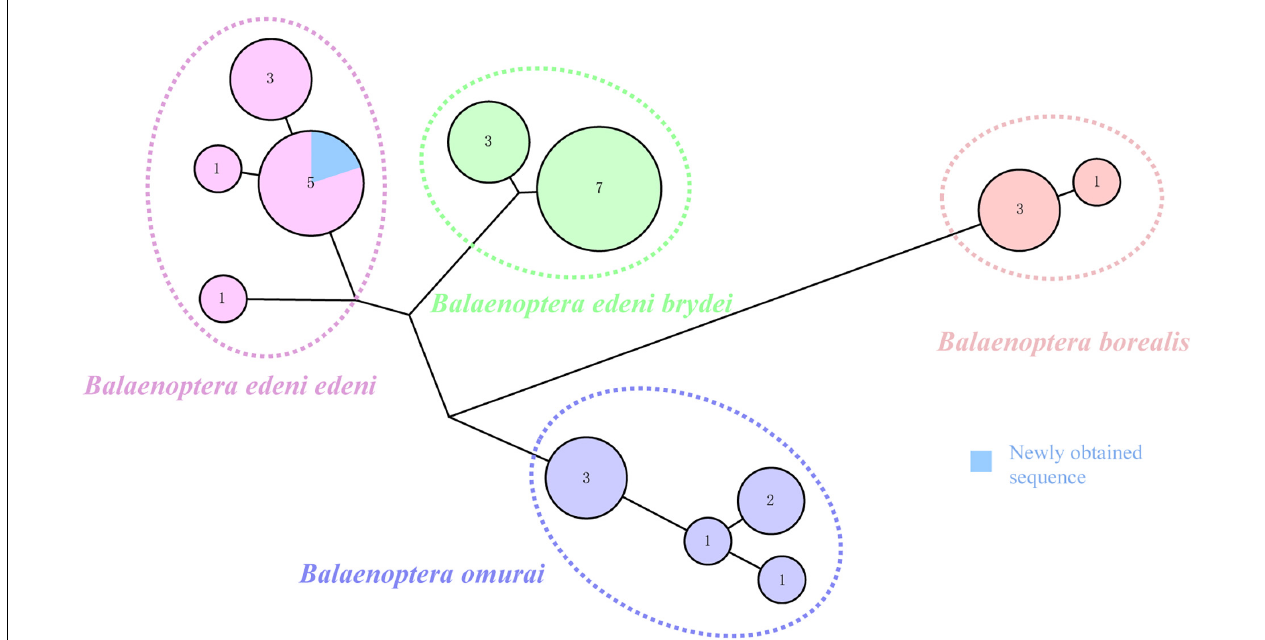
FIGURE 3 | Haplotype network of Bryde’s like, Sei and Omura’s whales based on the COI gene (515 bp). Each circle represents a unique haplotype and its size indicates the number of individuals carrying the haplotype. Color coding allow easy discrimination of species in the complex. Blue coloring represents a newly obtained sequence. Data for haplotypes from GenBank provided in Supplementary Table 3